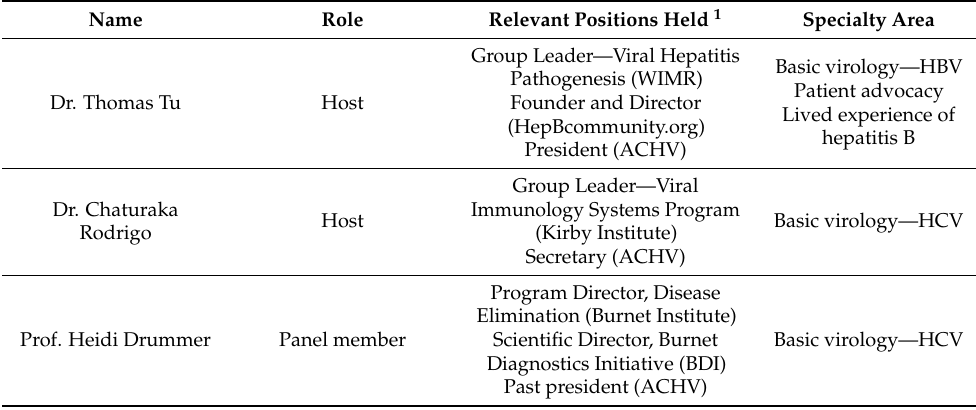
Table 1. Event hosts and panel